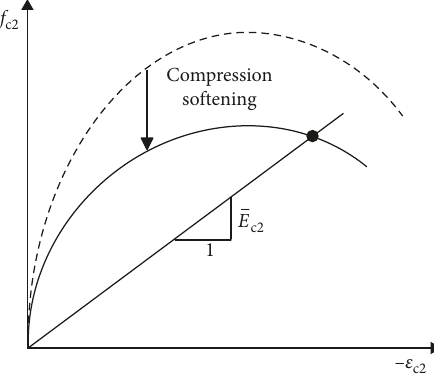
Figure 8: Concrete compression softening